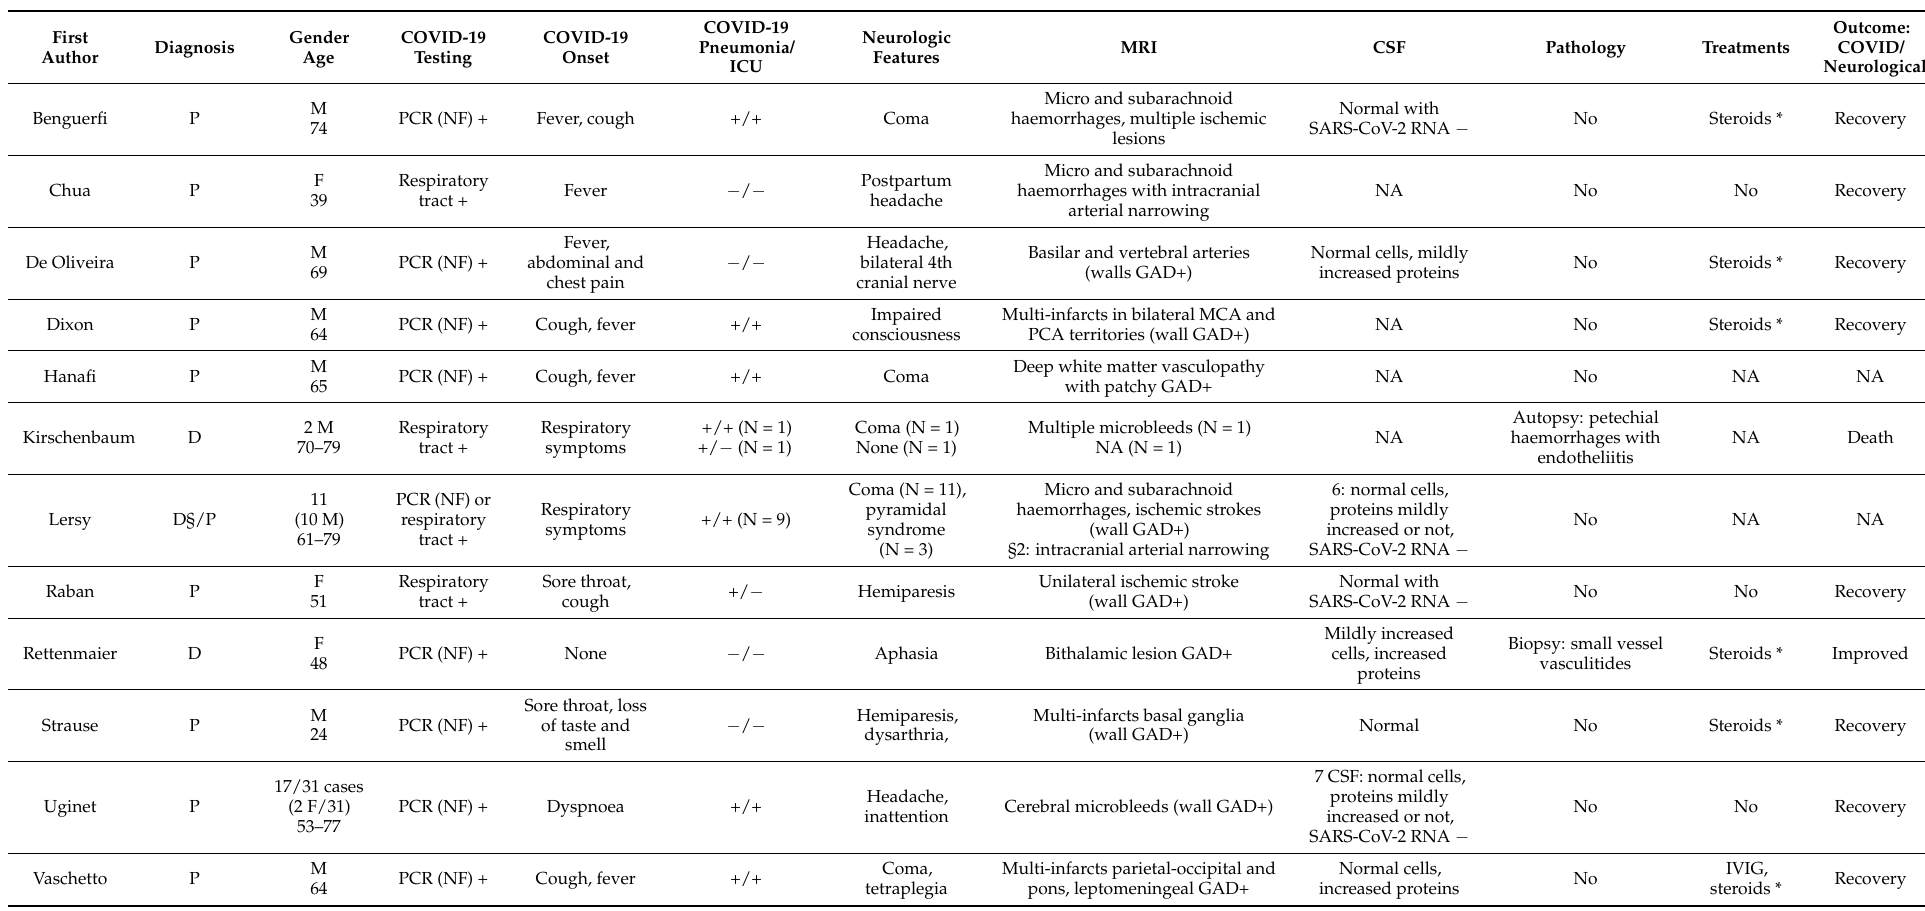
Table 1. Clinical characteristics of the included 39 cases with positive real-time polymerase chain reaction on nasopharyngeal swab or respiratory tract